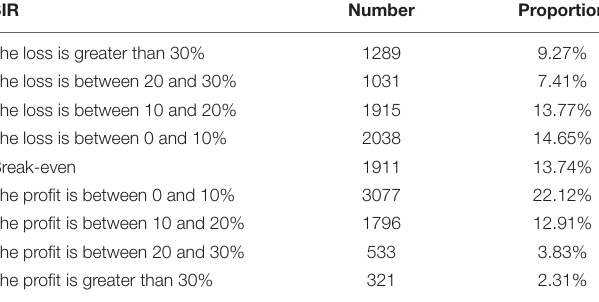
TABLE 2 | The summary of SIR.